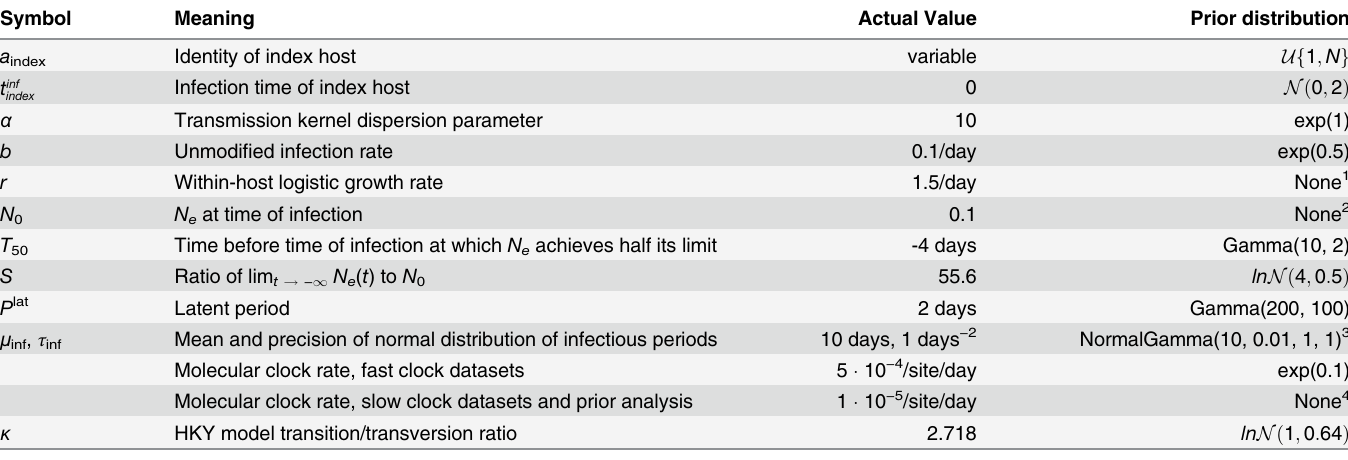
Table 2. Explanation of the mathematical symbols used in the simulation model, and prior distributions for their values used in analysis of the sim- ulated datasets. Mathematical symbols are given where they appear in the